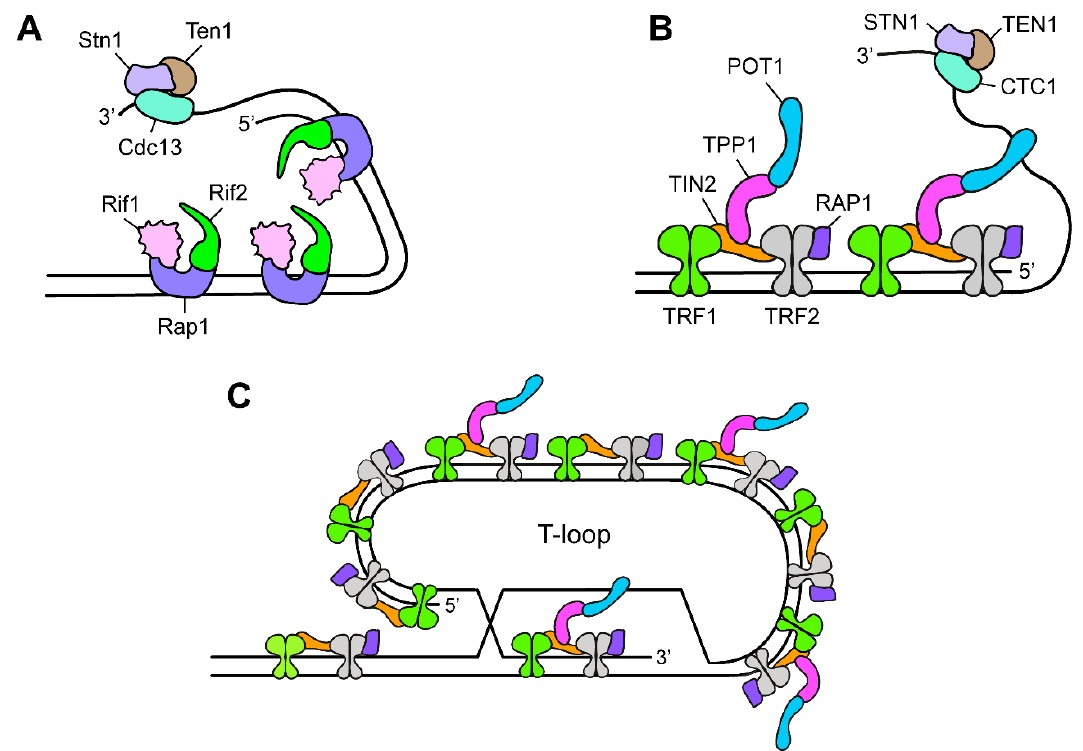
Figure 3. Telomeric structure and capping proteins in yeast and humans. ( A ) Schematic representation of the yeast Rap1-Rif1-Rif2 and CST complexes. CST in yeast is composed of Cdc13, Stn1, and Ten1 proteins. ( B ) Schematic representation of the mammalian shelterin complex, composed of TRF1, TRF2, TIN2, RAP1, TPP1, and POT1 subunits, and the CST complex, composed of CTC1, STN1 and TEN1 subunits. ( C ) The G-rich 3 ′ -ended single stranded overhang bound by the shelterin complex is looped back into the telomeric DNA to form a telomeric loop (T-loop).